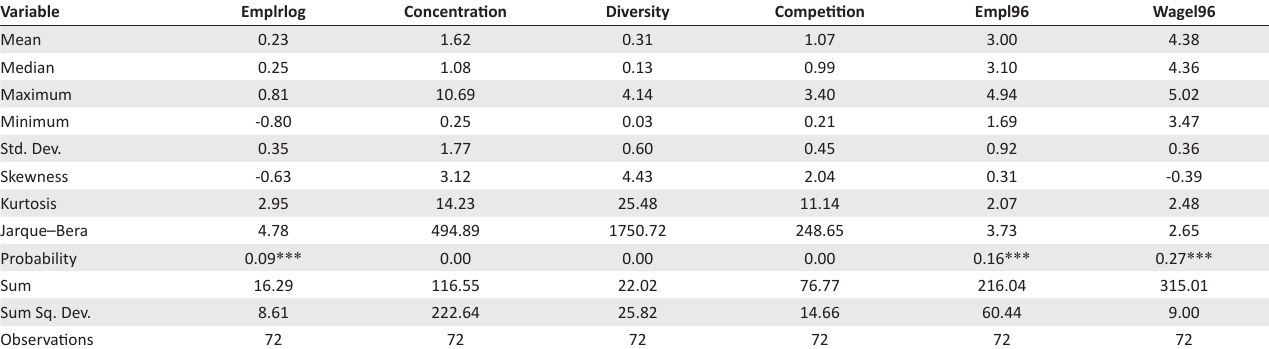
TABLE 10: Descriptive statistics.